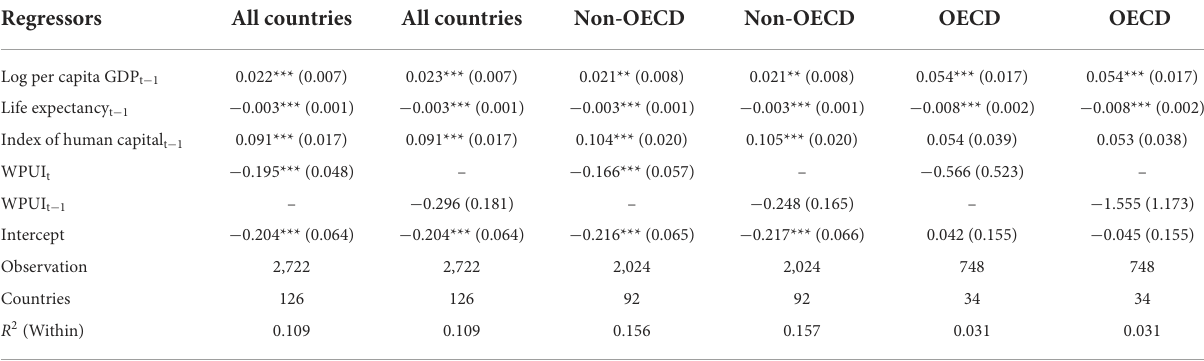
TABLE 2 Fixed-effects estimations for Model I